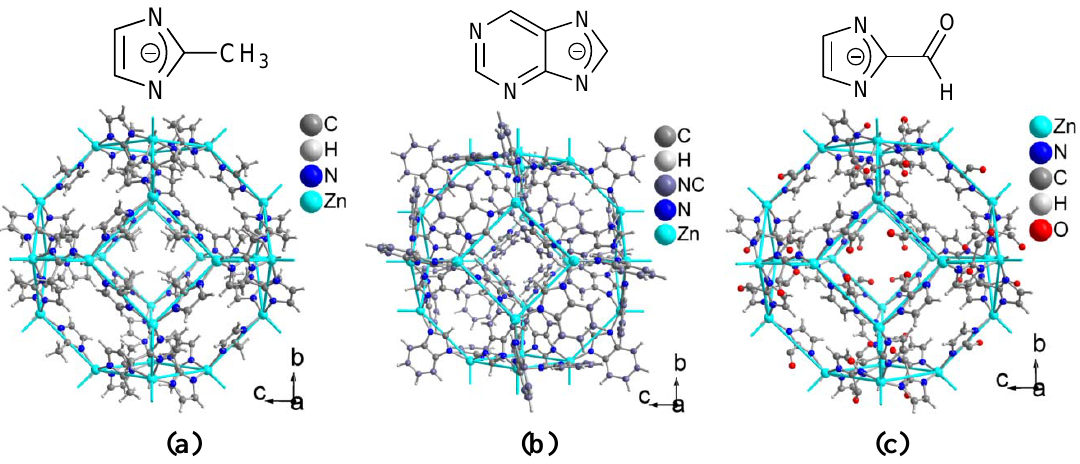
Figure 12. Linkers and sections of the packing diagrams emphasizing the cuboctahedral  -cage which is depicted by blue topological lines connecting the Zn atoms of ( a ) ZIF-8, ], ( b ) ZIF-20, [Zn(purinate) ] and ( c ) ZIF-90, [Zn(2-carboxyaldehyde [Zn(2-methylimidazolate) 2 2 imidazolate) 2